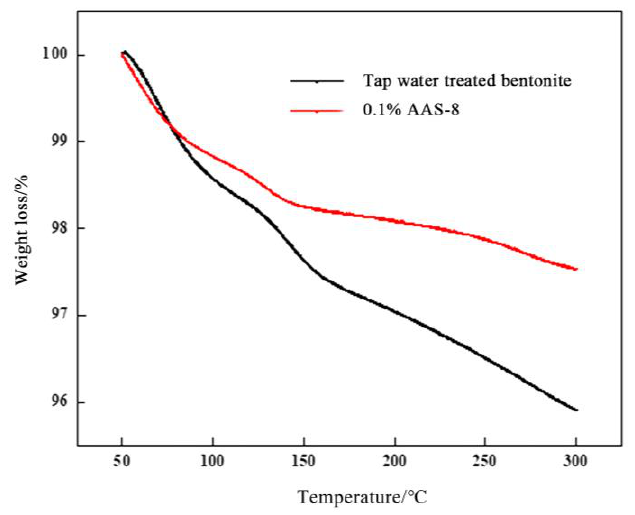
Figure 5. The thermal weight of bentonite under different treatments.